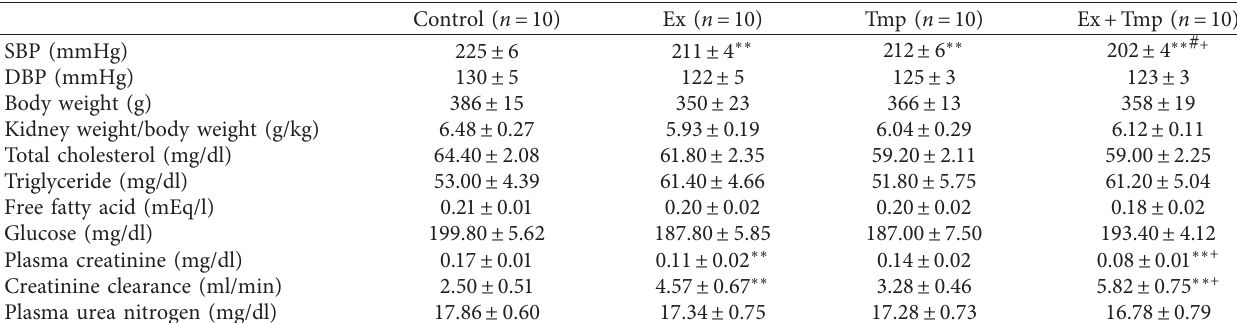
Table 2: Effects of Ex and tempol on the SBP and biochemical variables in